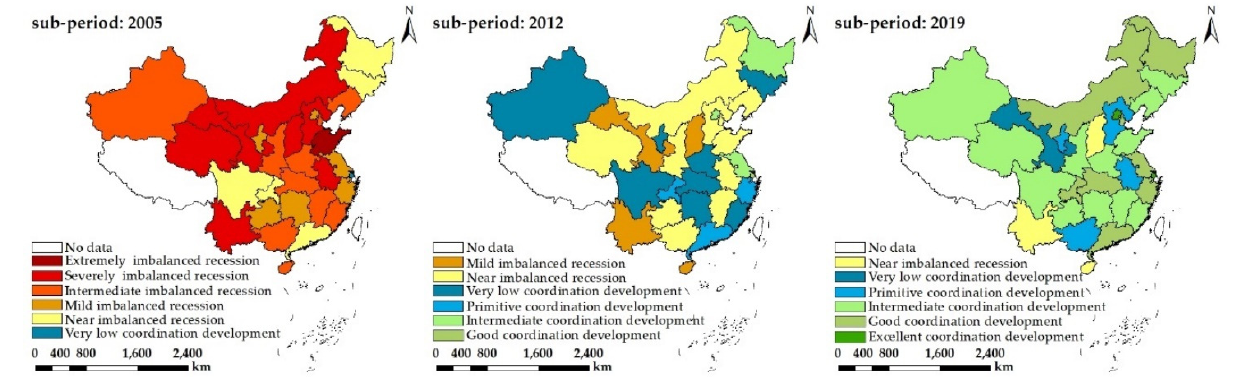
Figure 5. The coordination degree in regard to farmland transfer and CLGUE in China. No data— the data in Tibet, Taiwan, Hong Kong, and Macao are unavailable and unintegrated.